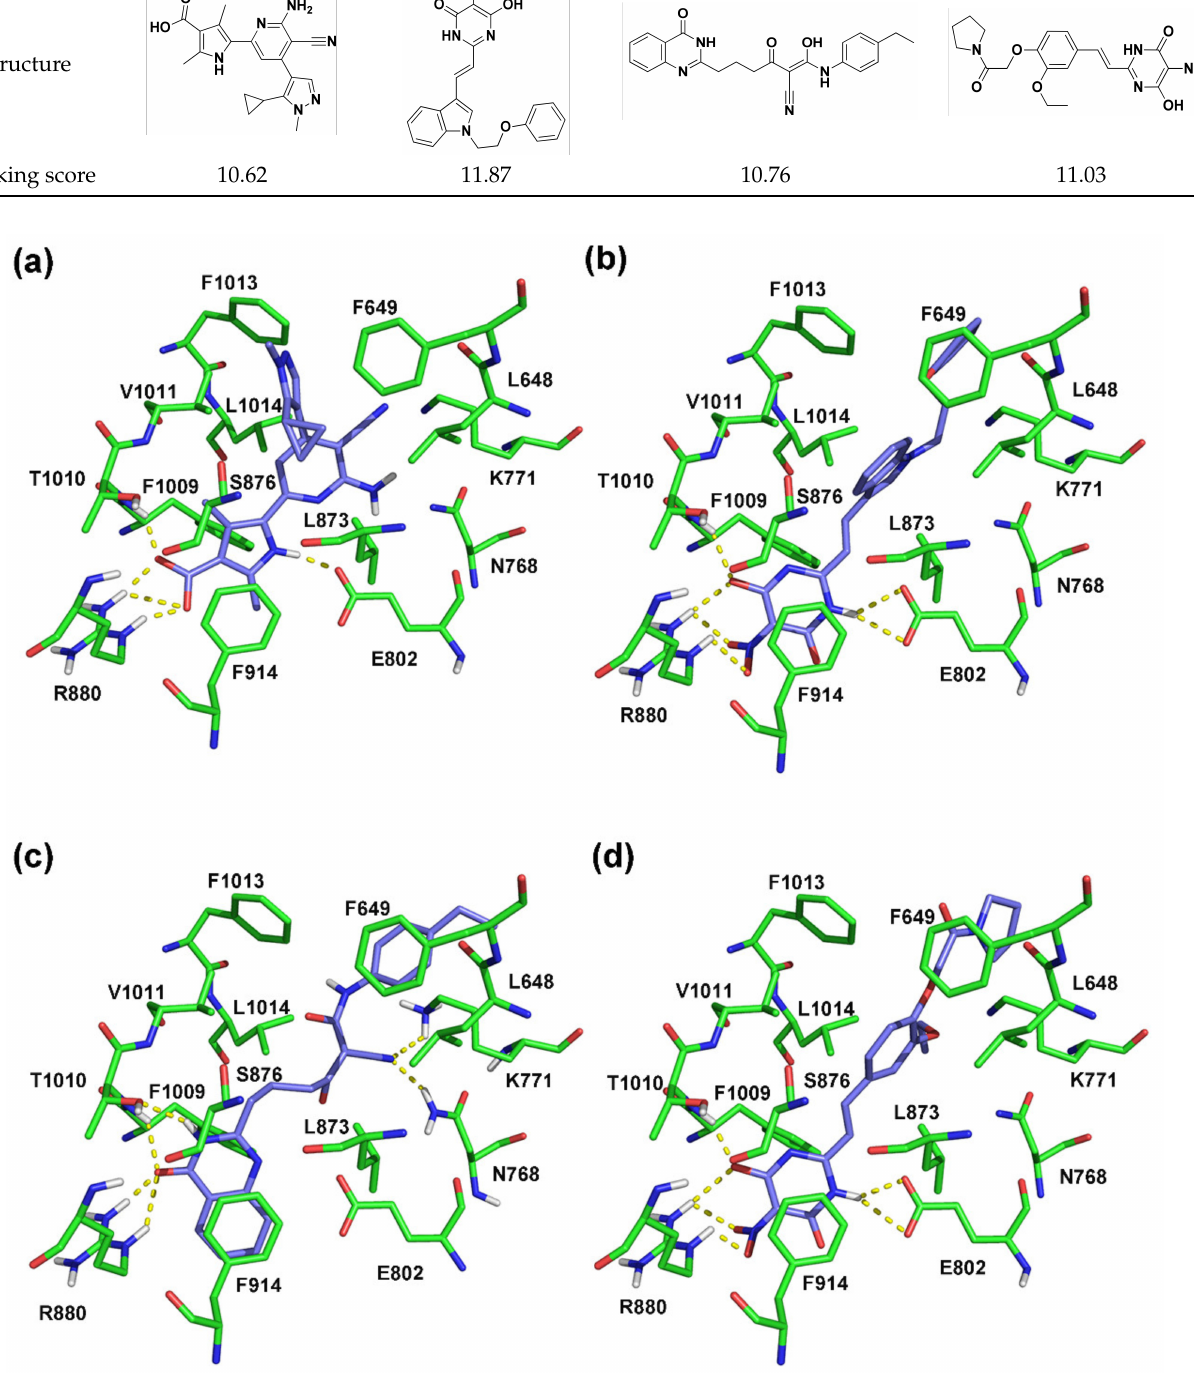
Figure 9. The docking results of the screened compounds VS12 ( a ), VS16 ( b ), VS19 ( c ), and VS26 ( d ) in the XO protein (PDB ID: 1N5X). The ligands, important residues, and hydrogen bonds were shown in blue sticks, green sticks, and yellow dashes,